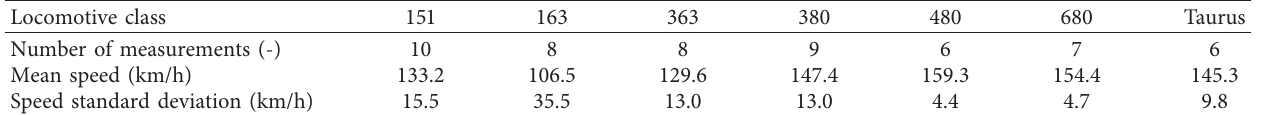
Table 2: Location 1: measured locomotives and their speeds.